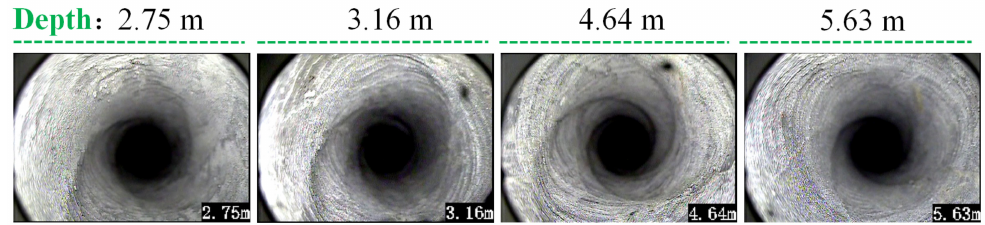
Figure 17. Peep chart of separation fractures in roof